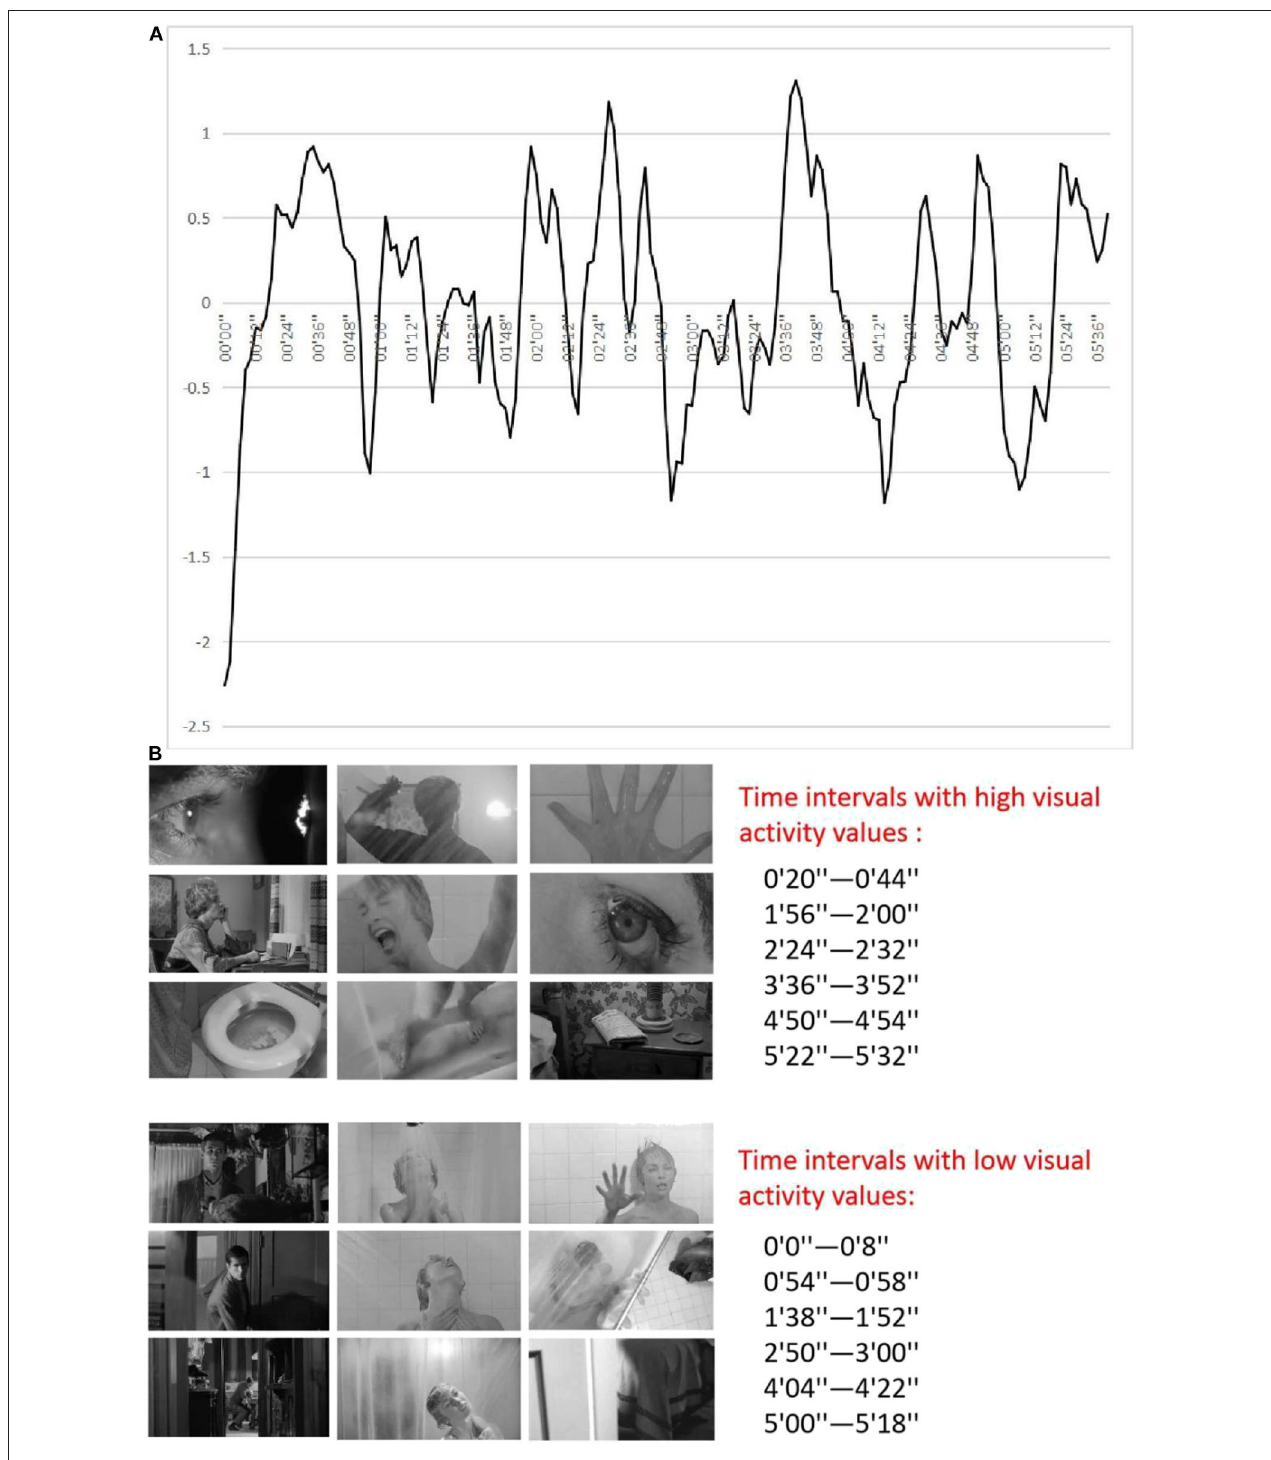
FIGURE 9 | (A) Average activity signals of visual brain regions over time. (B) Time intervals with high and low visual activity values and corresponding images.